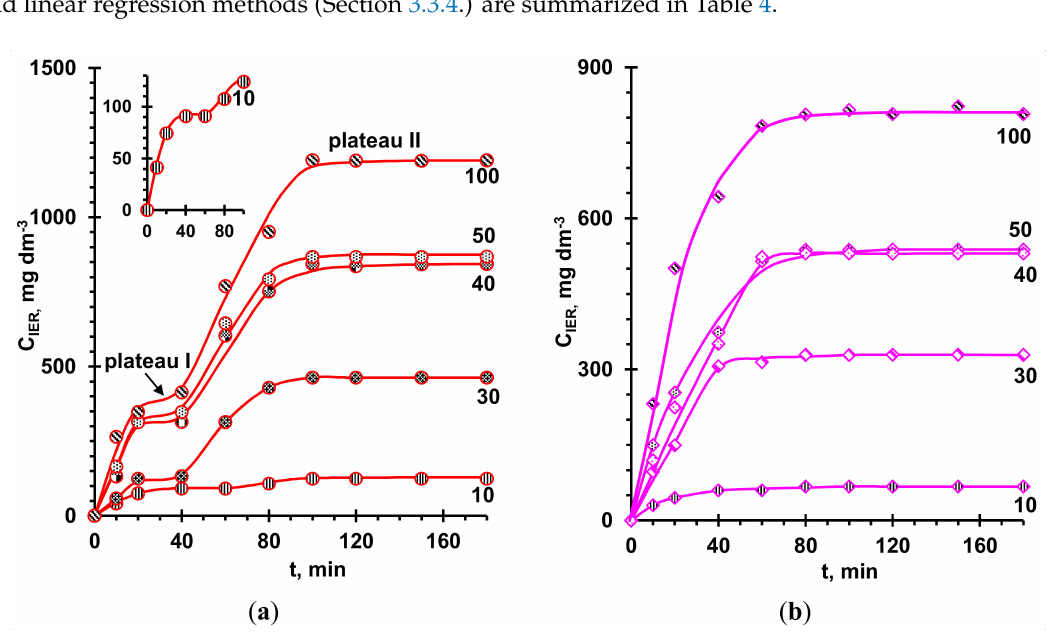
Figure 11. Kinetics of the anthocyanins adsorption by KU-2-8 ( a ) and AV-17-8 ( b ) ion-exchange resins from aqueous solutions with pH 3. The numbers near the curves indicate the concentration of anthocyanins in the solution, C S0 (mg dm − 3 ). Table 4. Fitting results of experimental equilibrium isotherms using equations of Langmuir, Freundlich, and Brunauer–Emmett–Teller (BET) models (Section